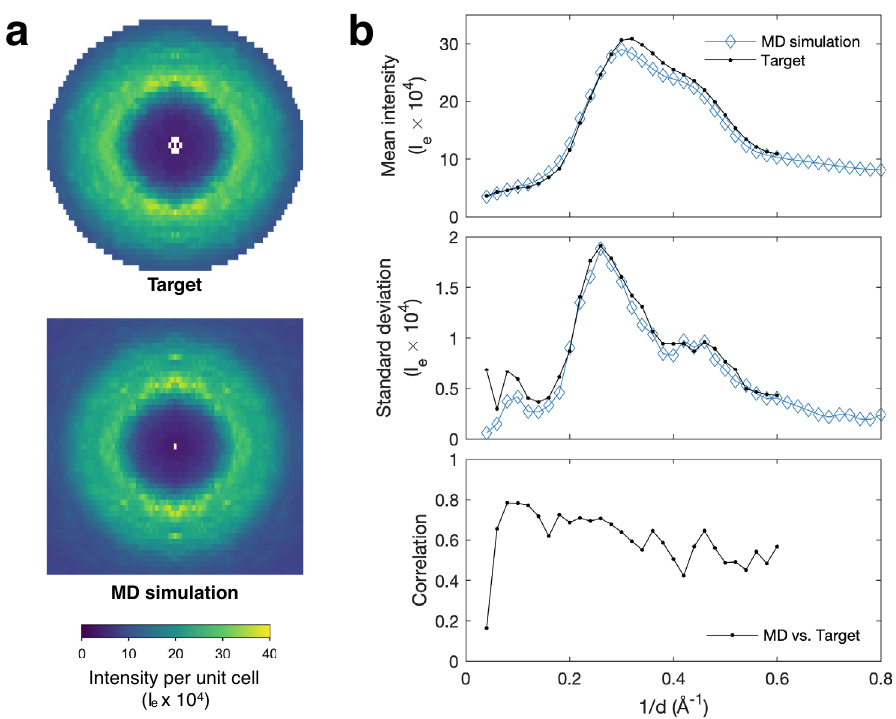
Fig. 6 | Direct comparison between target diffuse map and crystalline MD. MD simulations of tetragonal lysozyme were performed on a single unit cell with per- iodic boundary conditions (PBC) and a 3D diffuse map was simulated. a Slices through 3D maps of total diffuse intensity in the k = 0 plane from MD (bottom panel) and target map derived from experimental data and GOODVIBES fi t (top panel)inelectronunits(I e )perunitcell.SeeMethodsandSupplementaryFig.6afor details. b DirectcomparisonofMDandtargetdiffusemapsineachresolutionshell (1 = d is the scattering vector magnitude, d is the resolution). The average diffuse